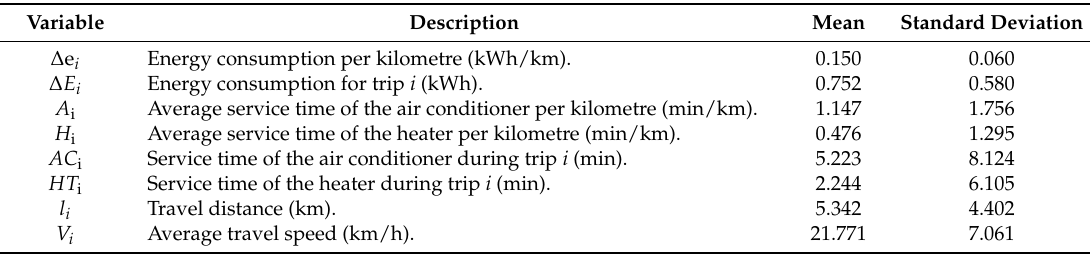
Table 1. Descriptive statistics of the